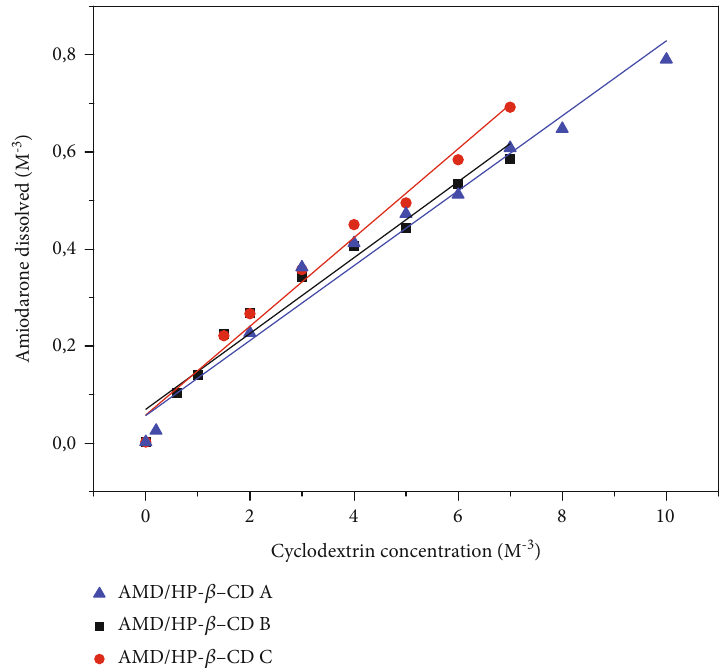
Figure 10: Solubility diagram of the three inclusion complexes in water: AMD/HP- β -CD A, AMD/HP- β -CD B, and AMD/HP- β -CD C.